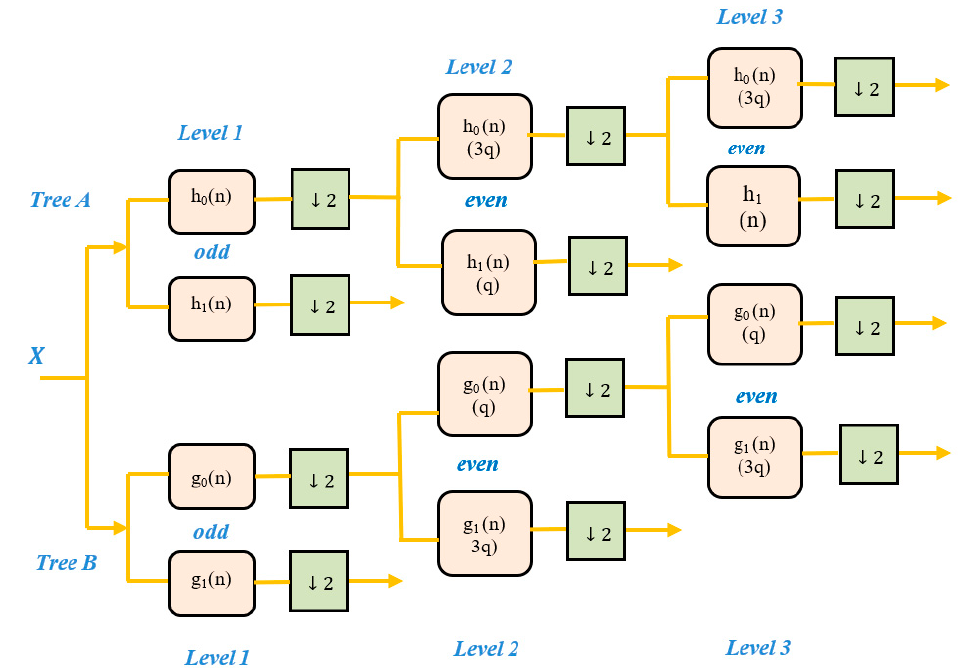
Figure 3. The qshiftN DTCWT filter’s structure.